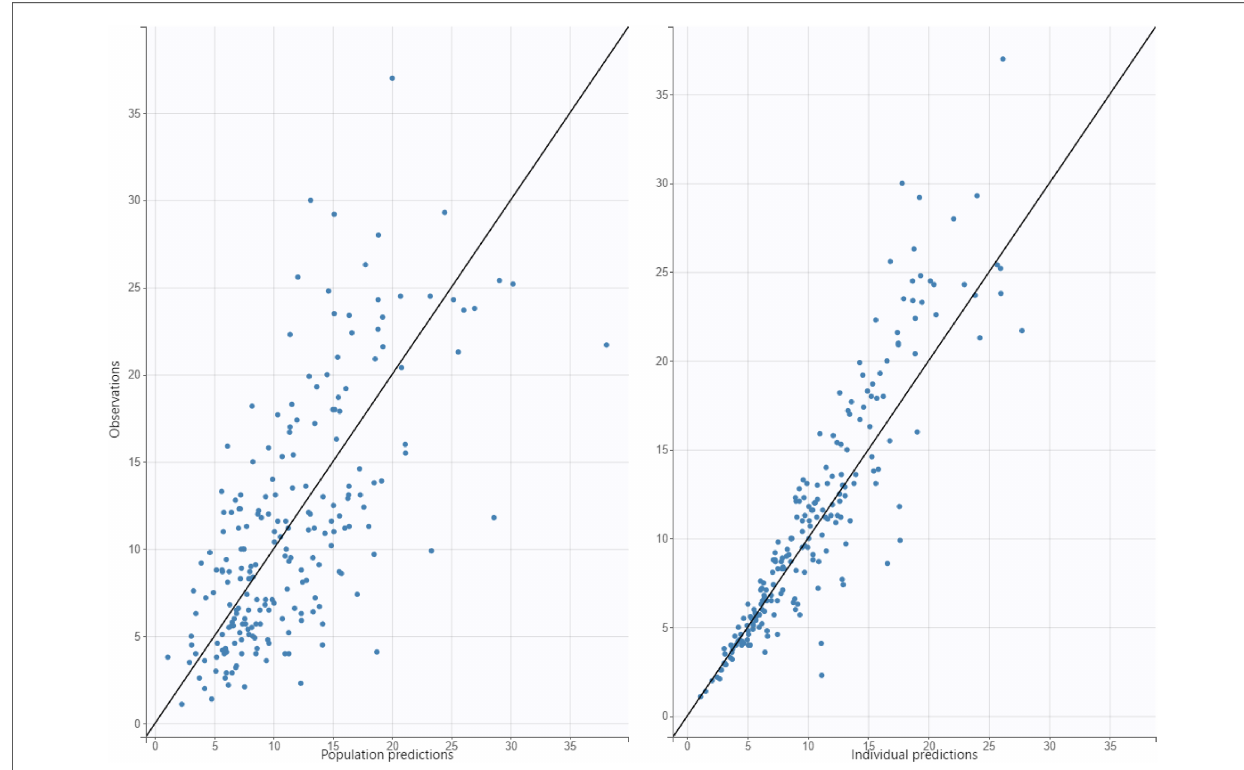
FIGURE 2 Diagnostic plot for observed concentrations vs. predicted concentrations, fi gure on left is population predictions, fi gure on right is individual